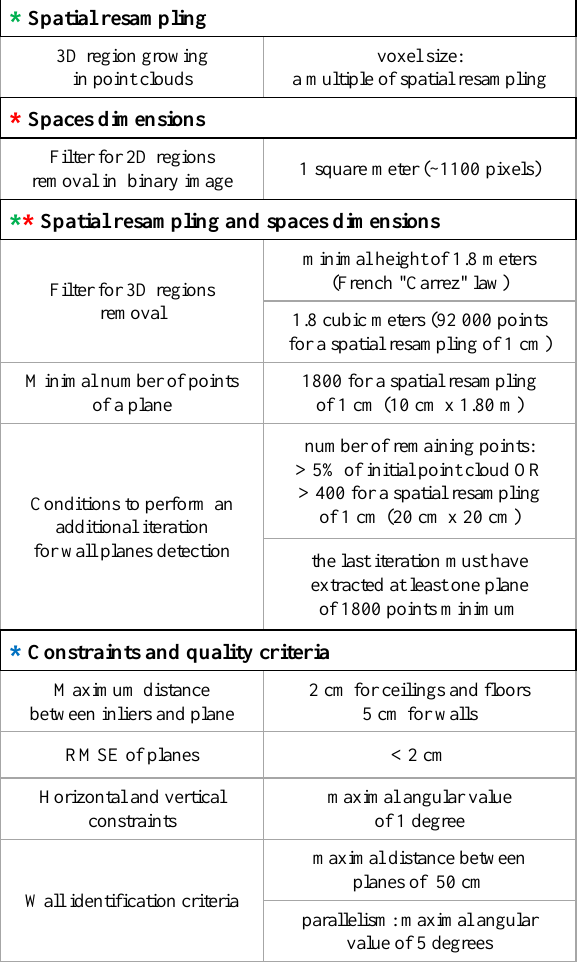
Table 6. Main thresholds involved in the developed